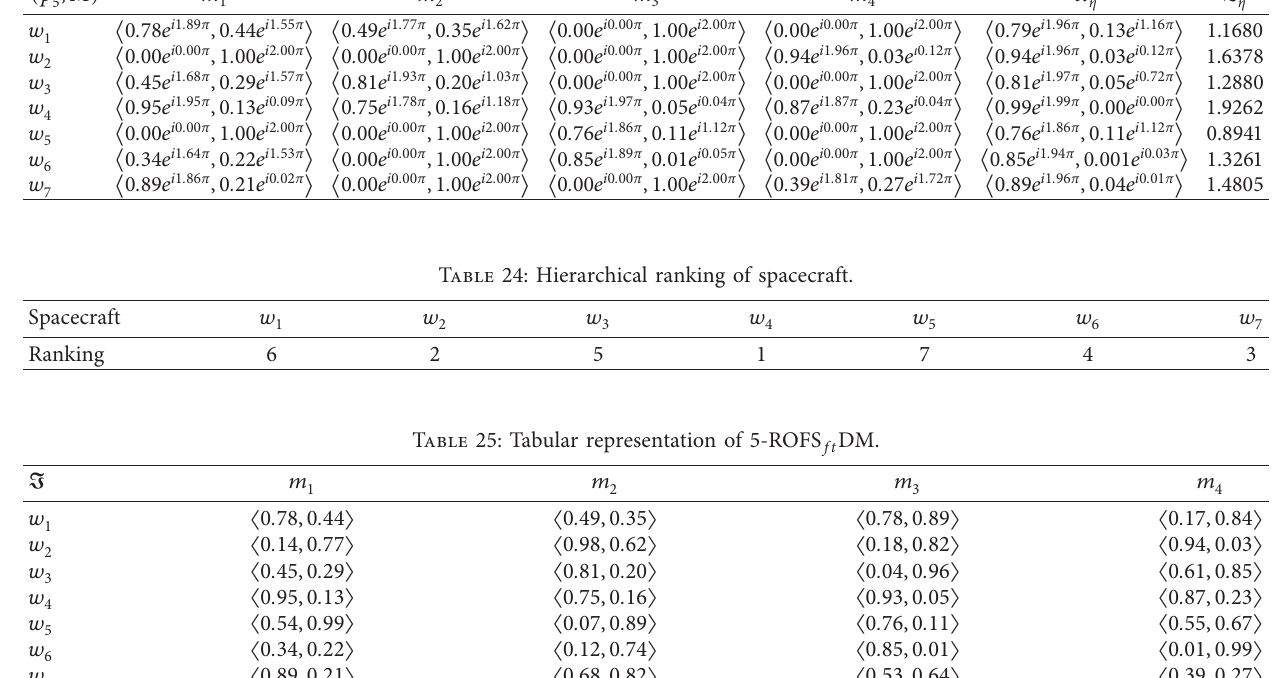
Table 23: 3-choice values of C